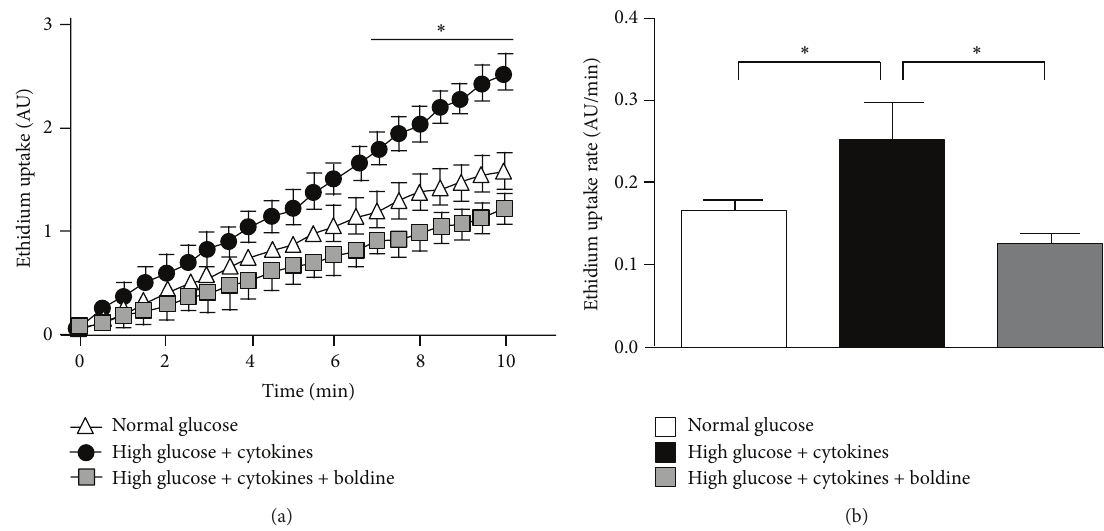
Figure 6: Boldine reduces the increase in Etd uptake induced by high glucose + cytokines in mesangial cells. (a) The graph shows time- lapse measurements of fluorescence intensity of Etd bound to nucleic acids of mesangial cells cultured for 48 h under normal glucose (white triangle),highglucose+cytokines(TNF- 𝛼 (10ng/mL)andIL-1 𝛽 (10ng/mL))(blackcircles),andhighglucose+cytokinestreatedwith100 𝜇 M Boldine for the last 24h (grey square). (b) Each bar represents the mean value of the rate of Etd uptake obtained from time-lapse curves. Mean ± SEM for 4 independent experiments. Normal glucose (White bar), high glucose + cytokine (black bar), or high glucose + cytokine with 100 𝜇 M boldine (grey bar) for 24h; ∗ 𝑃 ≤ 0.05 using one-way ANOVA test followed by Bonferroni’s post hoc